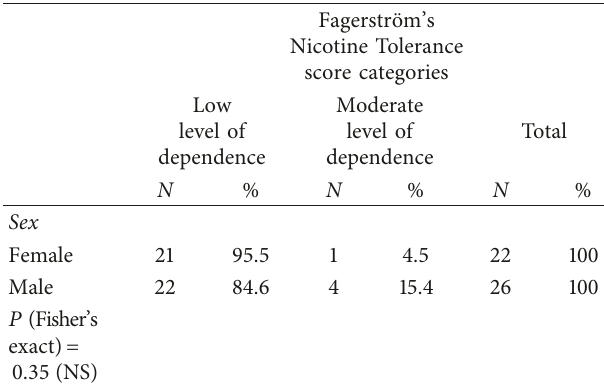
Table 8: Nicotine dependence level among current shisha smokers by